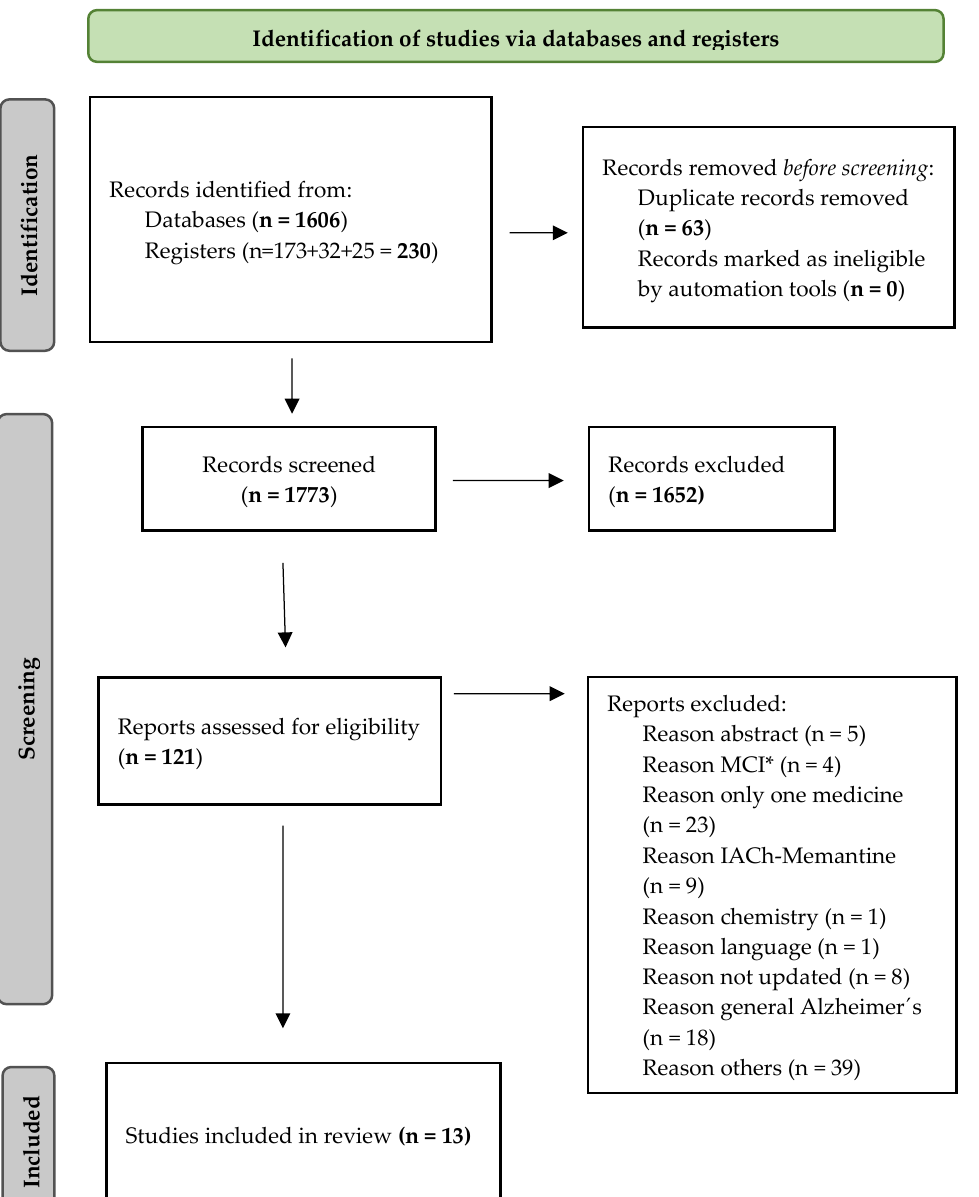
Figure 1. Preferred Reporting Items for Systematic Reviews and Meta-Analyses (PRISMA) [12] flow diagram. Search algorithm. *Mild cognitive impairment.